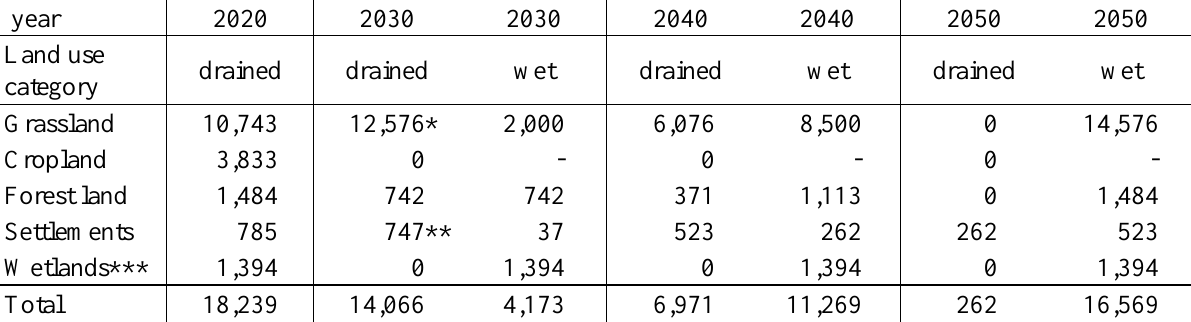
Table 1. Drained and rewetted area (km 2 ) of organic soil per land use category in Germany under the proposed emission reduction pathway 1 (2020 data estimated based on UBA 2019).